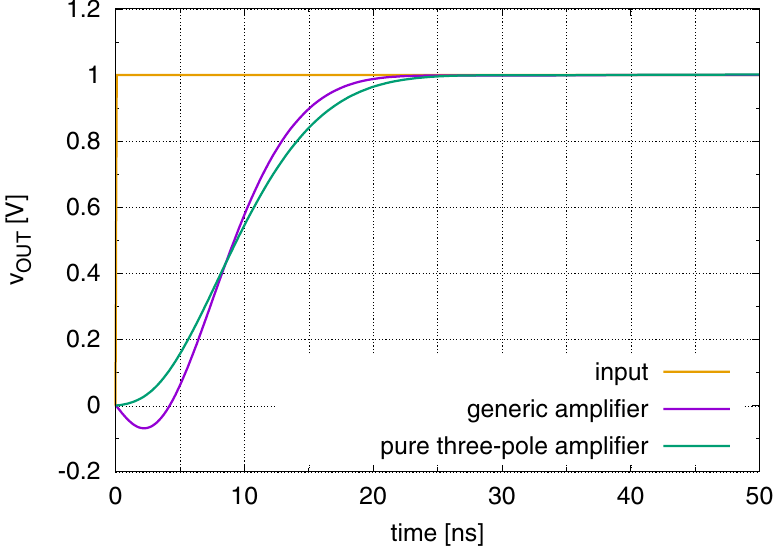
Figure 6. Time-domain behavior of two three-pole amplifiers in response to a unity step input. The two amplifiers are designed with the same GBW and separation factors.